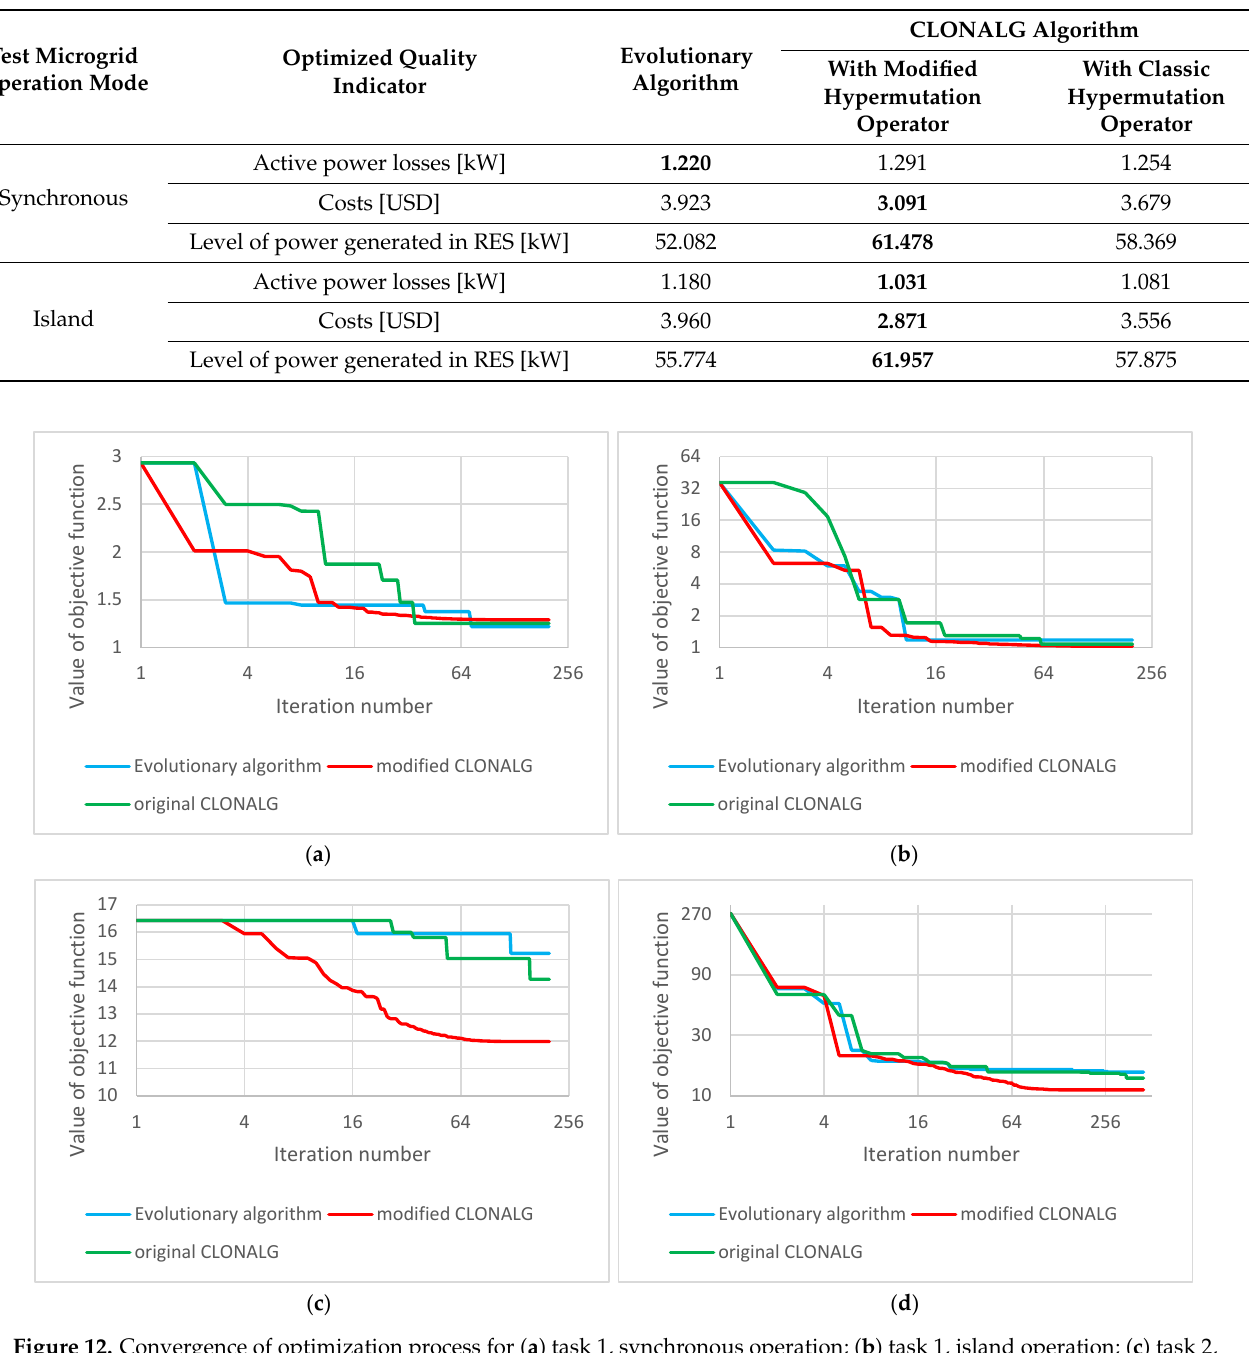
Table 8. Comparison of results of optimization calculations for the microgrid island operation.